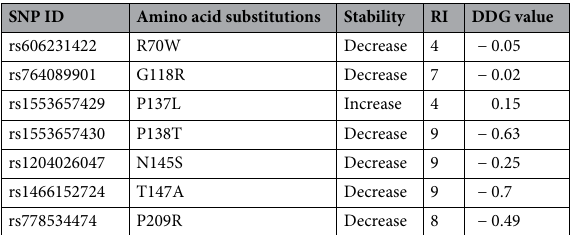
Table 2. I-Mutant predicted CTLA4 protein stability due to deleterious